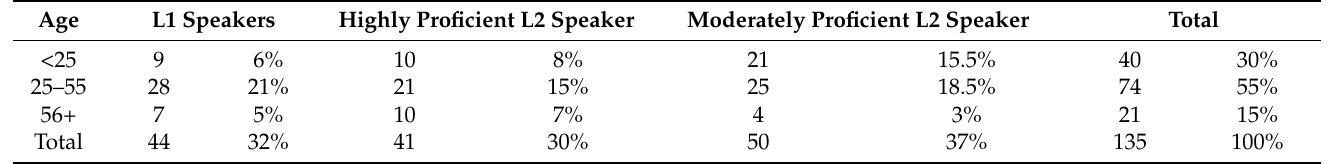
Table 2. Adult participants by language background and